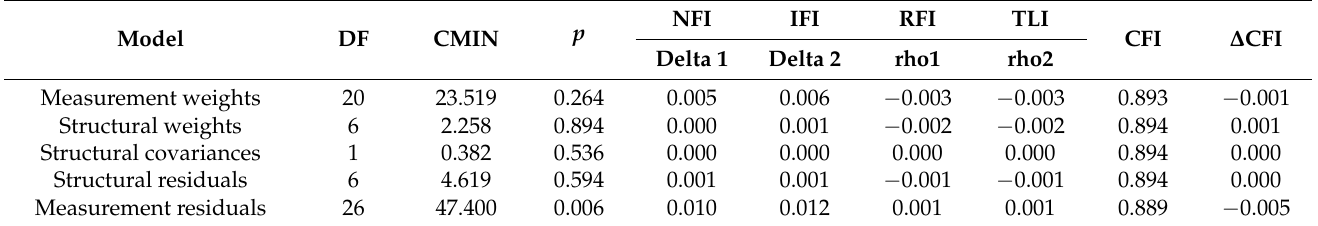
Table 7. Comparison of whether structural models are involved in after-school service clusters without deformation.